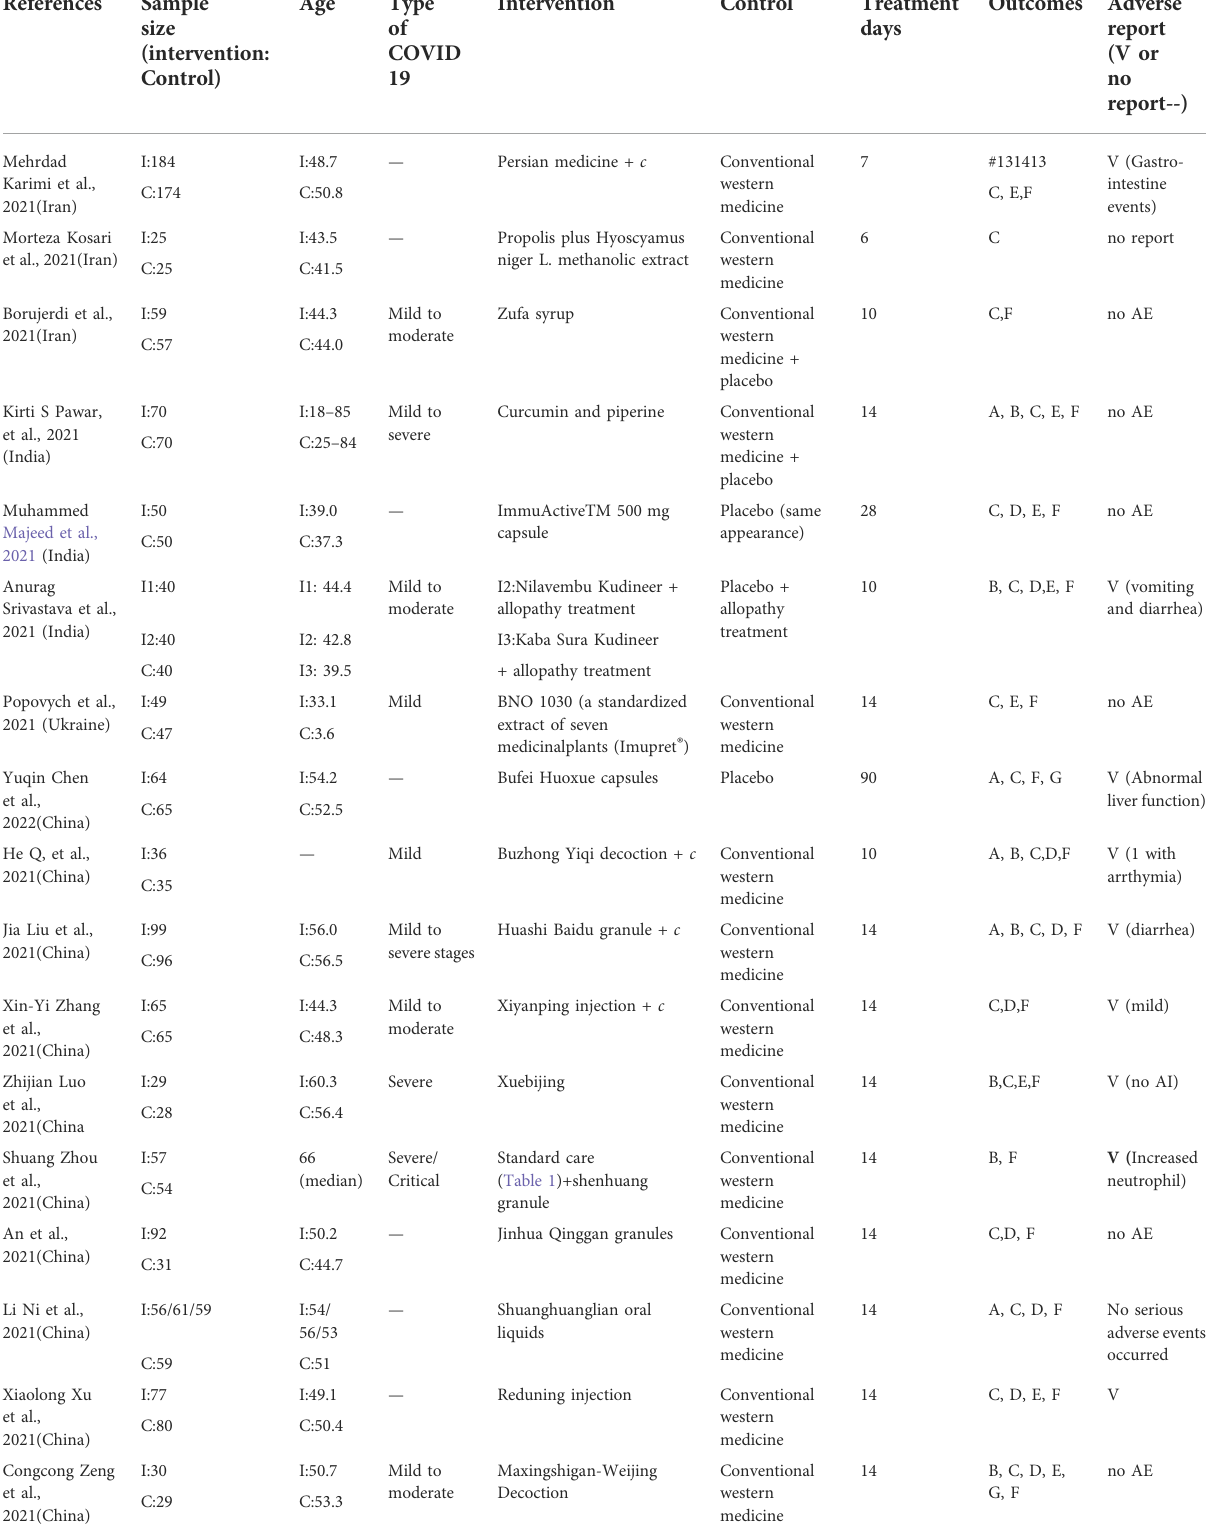
TABLE 1 The characteristics of the included